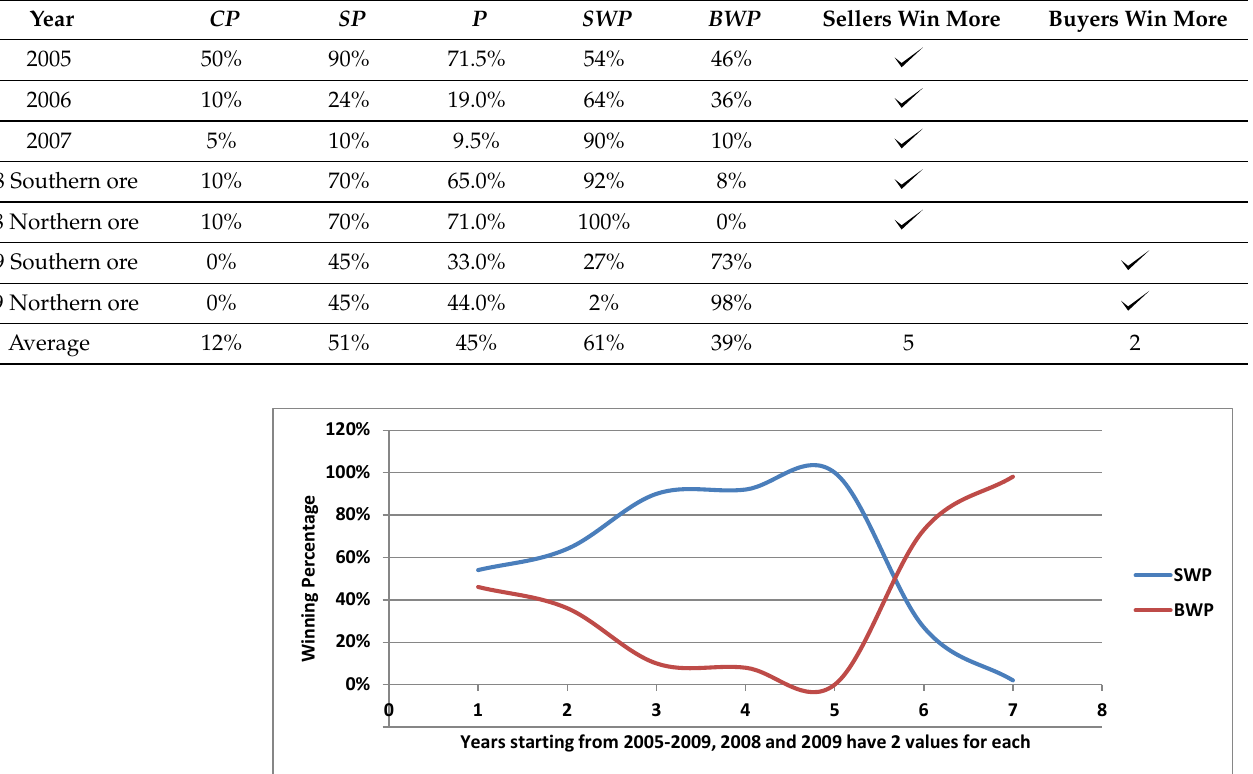
Figure 5. Sellers’ and buyers’ winning percentages in the ore